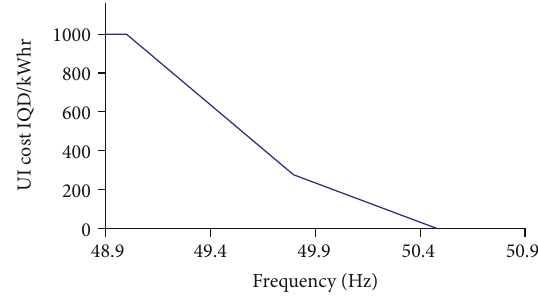
Figure 2: UI cost vs. frequency